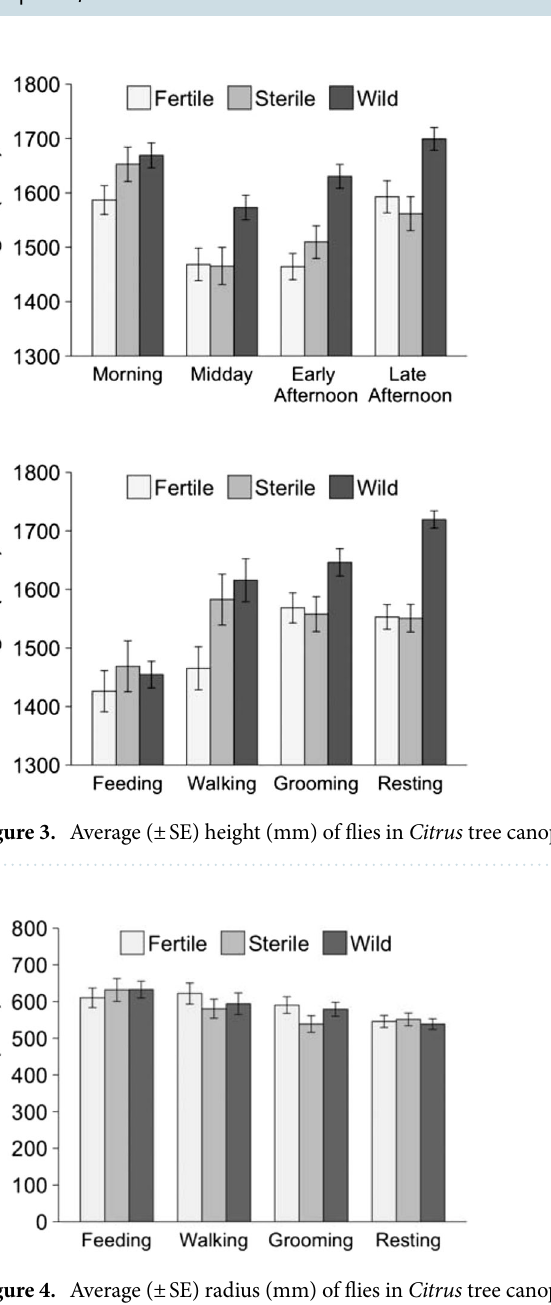
Figure 4. Average (± SE) radius (mm) of flies in Citrus tree canopies by